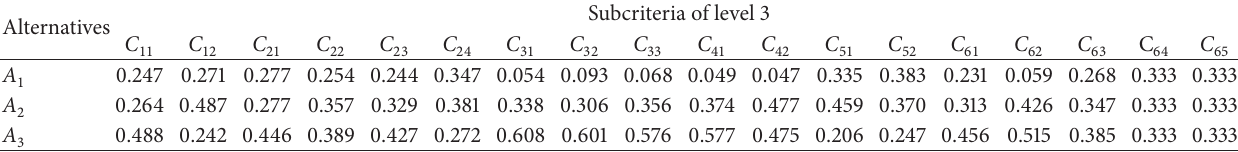
Table 9: The aggregate weights of pairwise comparison matrices for subcriteria of level 3 and